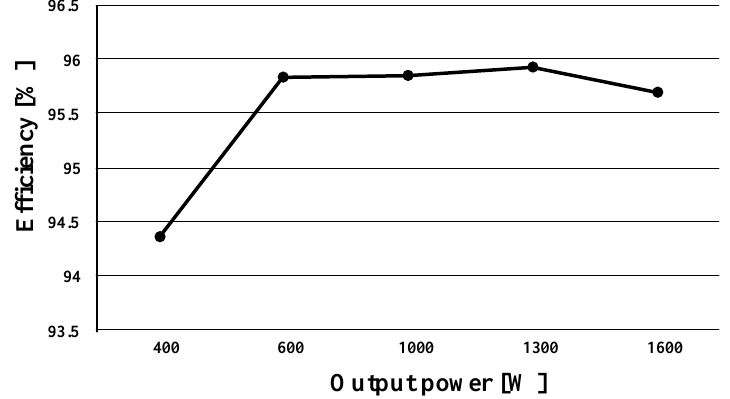
ffi ciency according to output Figure 11. Power conversion efficiency according to output power. Figure 11. Power conversion e